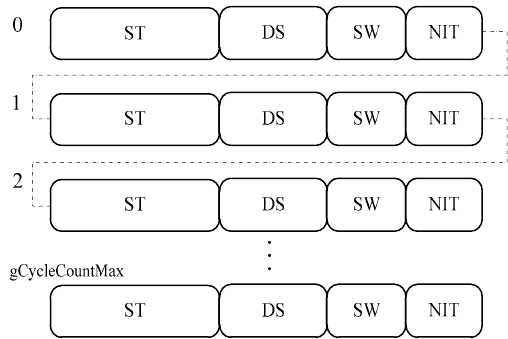
Figure 1. FlexRay communication cycle. ST, static segment; DS, dynamic segment; SW, symbol window; NIT, network idle time.